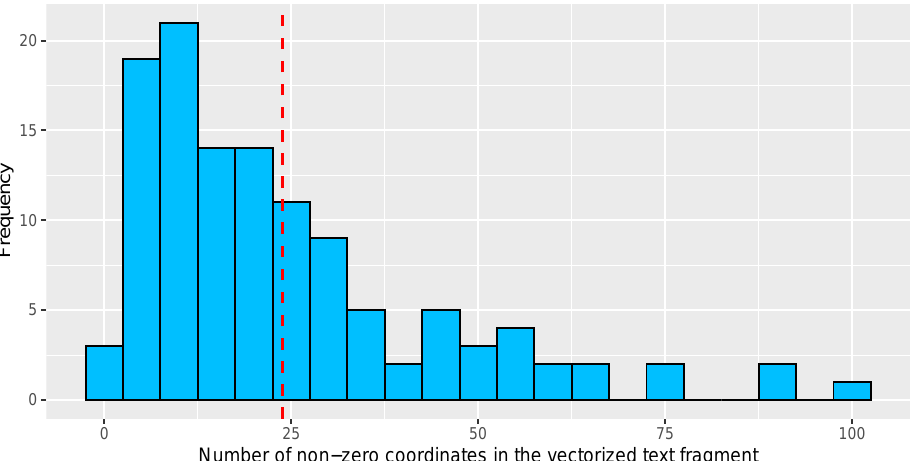
Figure 3. Histogram showing the small concentration of non-zero coordinates in the vectorized training set. The horizontal axis shows the number of coordinates that are non-zero in the vectors resulting from the vectorization of the text fragments conforming the training set, while the vertical axis shows the absolute frequency of occurrence. The red vertical dashed line represents the average number of coordinates that are non-zero in the vectorized text fragments that form the training